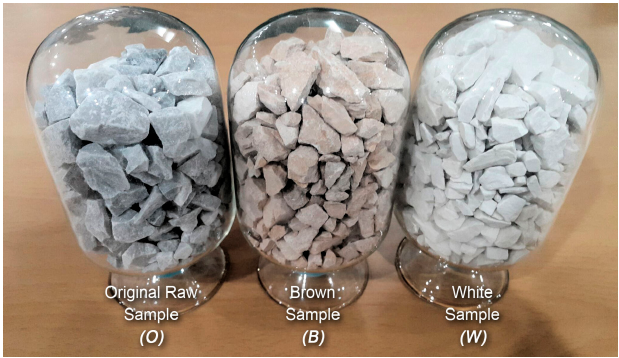
Figure 2. Three types of sample material groups; original raw sample ( O ), brown sample ( B ) and white sample ( W ).